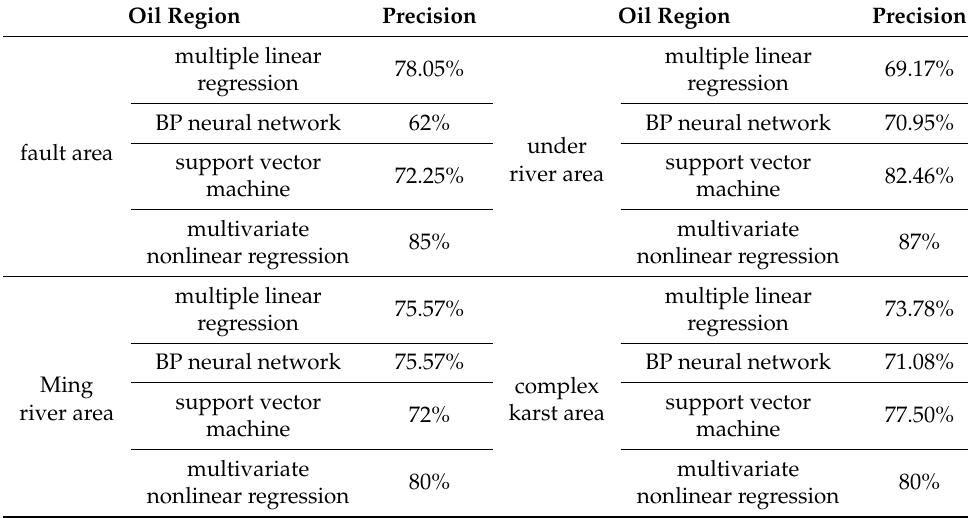
Table 4. Comparison of various